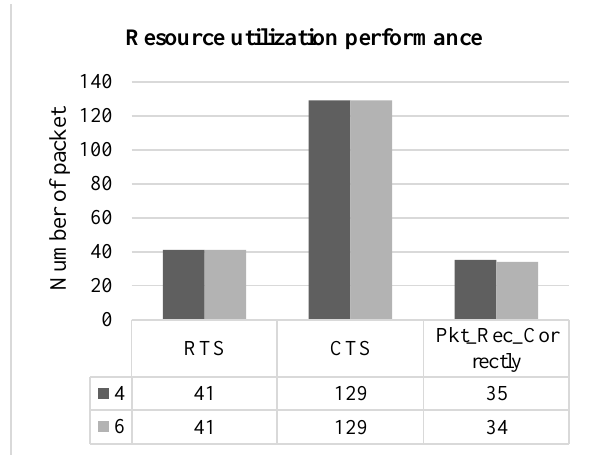
Figure 1 Resource utilization performance